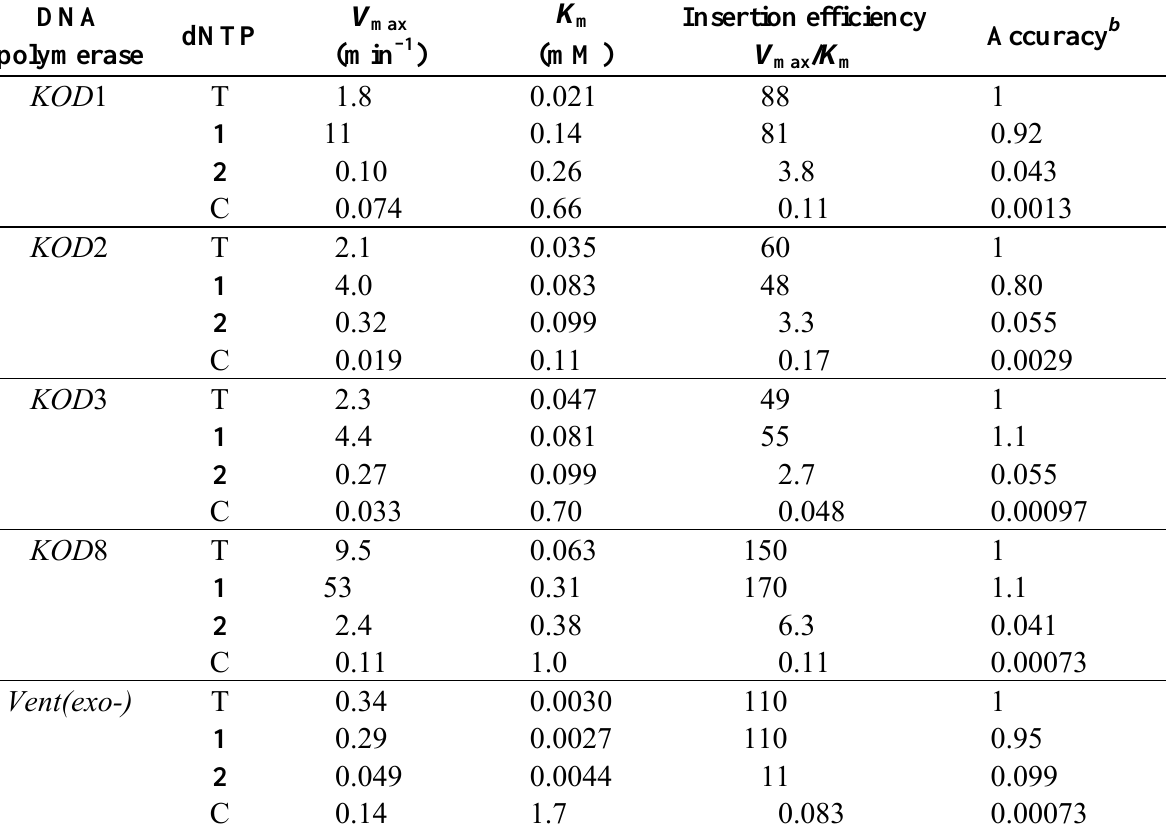
a Experimental conditions are described in Experimental Section. b The initial rate relative apparent insertion efficiency (accuracy); ( V